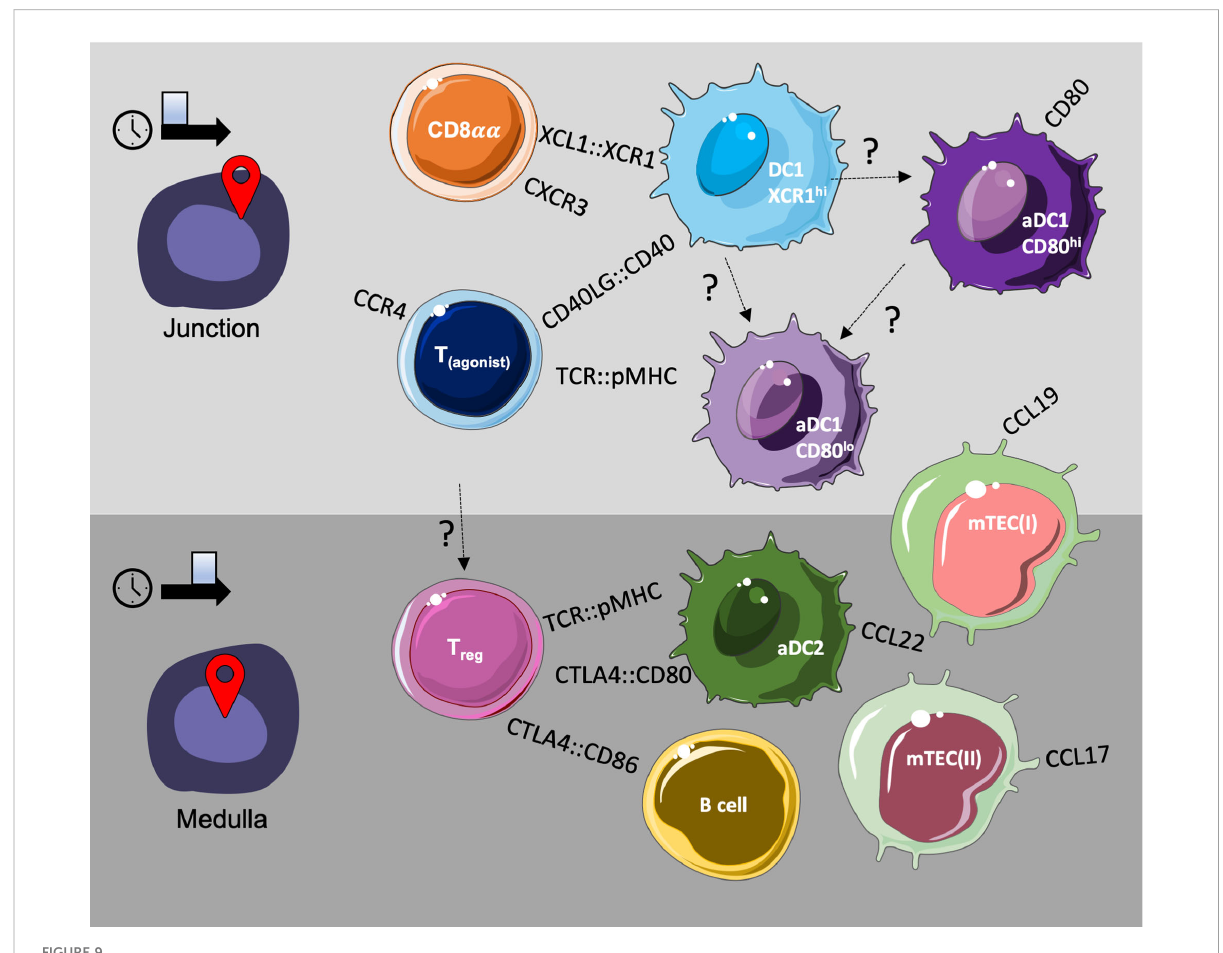
FIGURE 9 Putative model of the cellular milieu for T agonist selection in the